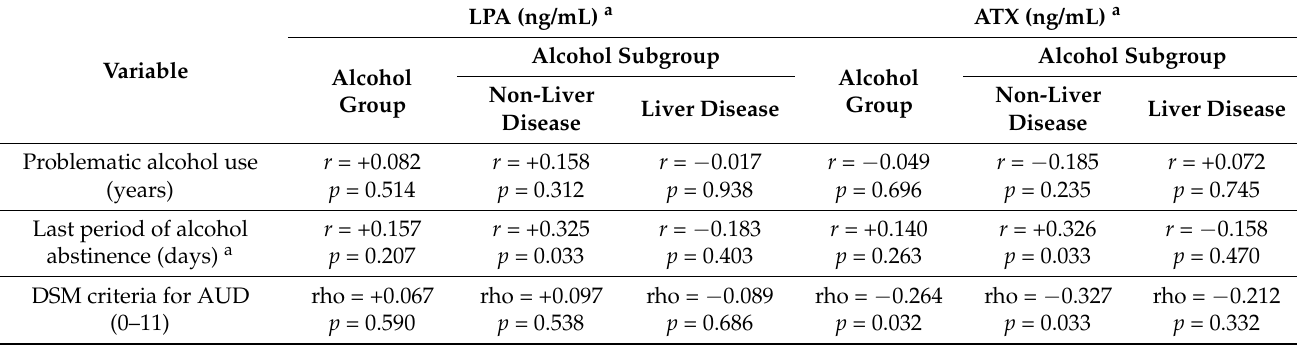
Table 3. Correlation analysis between AUD-related variables and plasma concentrations of LPA and ATX.